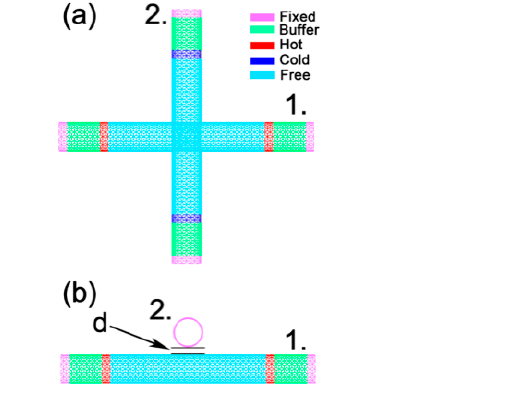
Figure 1. The calculation model for the thermal contact conductance of two carbon nanotubes with a single thermal contact: ( a ) aerial view; ( b ) front view.